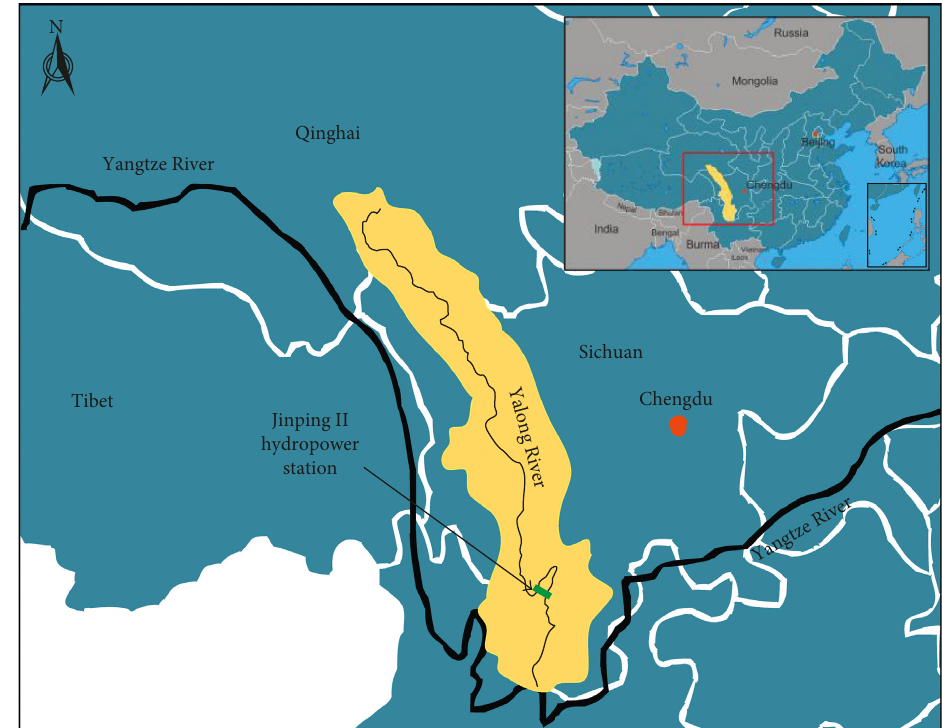
Figure 1: Location of the Jinping II hydropower